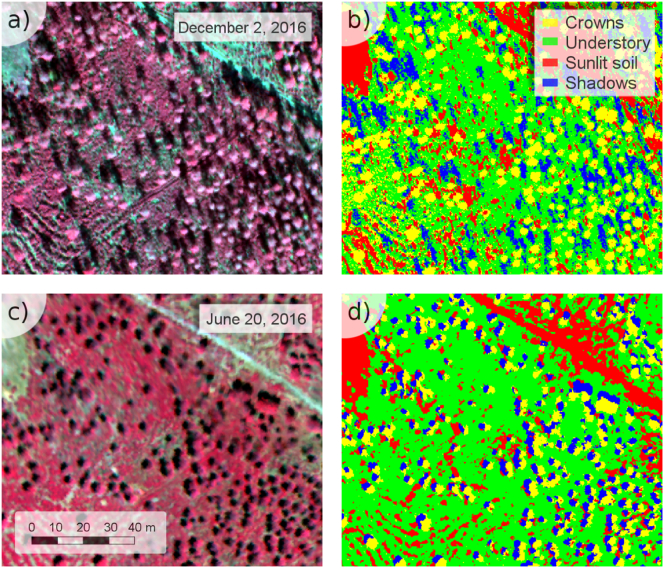
Classification conducted on the December (a, b) and June (c, d) hyperspectral images to generate the four scene components: i) pure tree crowns, ii) understory vegetation, iii) sunlit soil, and iv) shadows.